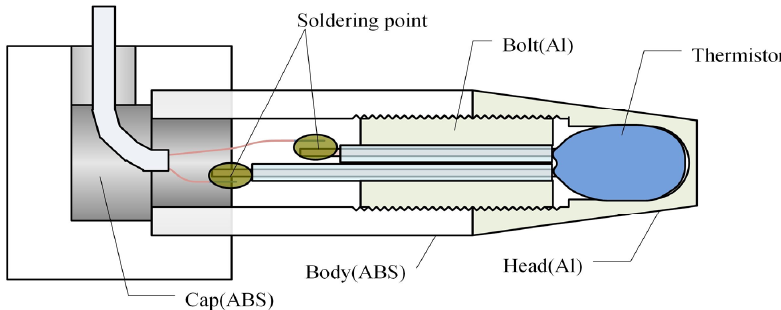
Figure 1. Cross-sectional view of probe (Al: aluminum, ABS: Acrylonitrile butadiene styrene).